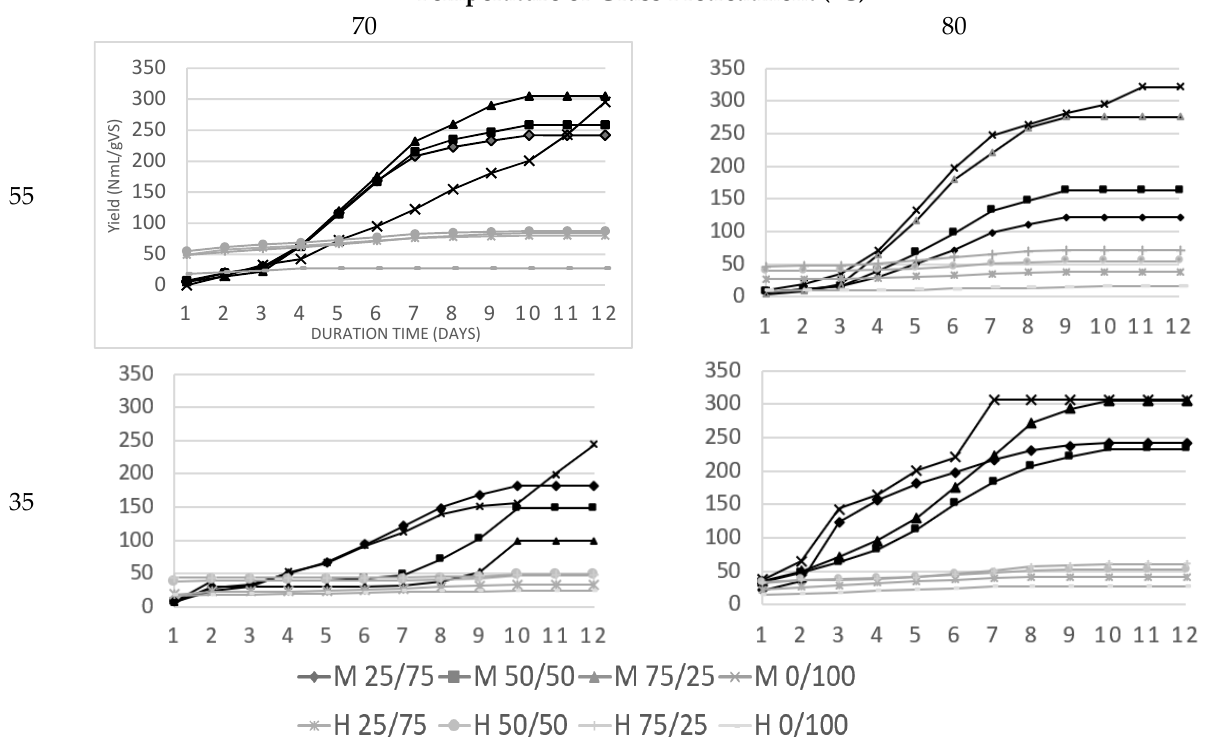
Figure 1. Cumulative methane and hydrogen yields from co-digestion of kitchen waste and grass after hyperthermophilic pretreatment. M 25/75—mesophilic co-digestion of pretreated grass with 25% addition of kitchen waste. M 50/50—mesophilic co-digestion of pretreated grass with 50% addition of kitchen waste. M 75/25—mesophilic co-digestion of pretreated grass with 25% addition of kitchen waste. M 0/100—mesophilic mono-digestion of pretreated grass. T 25/75—thermophilic co-digestion of pretreated grass with 25% addition of kitchen waste. T 50/50—thermophilic co-digestion of pretreated grass with 50% addition of kitchen waste. T 75/25—thermophilic co-digestion of pretreated grass with 25% addition of kitchen waste. T 0/100—thermophilic mono-digestion of pretreated grass.